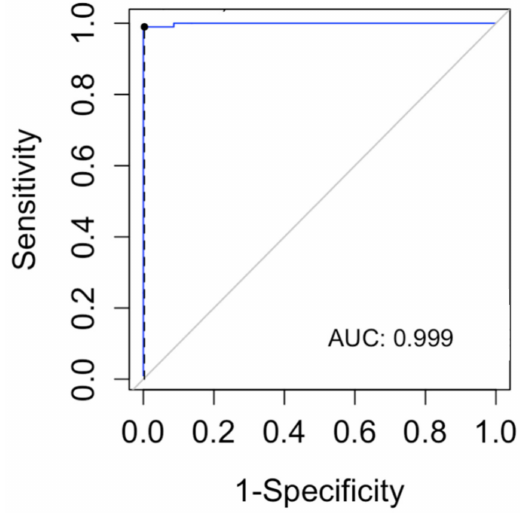
Figure 3. The receiver operating characteristic (ROC) curve was used to evaluate the lyso-Gb1 ability for classifying Gaucher disease vs. no Gaucher disease. The area under the curve (AUC) was calculated.